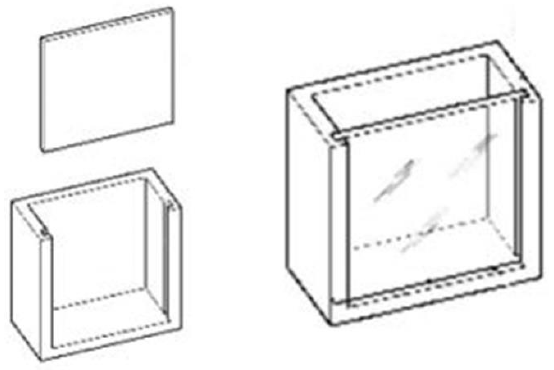
Figure 1. Case for irradiation with gamma-rays [2].